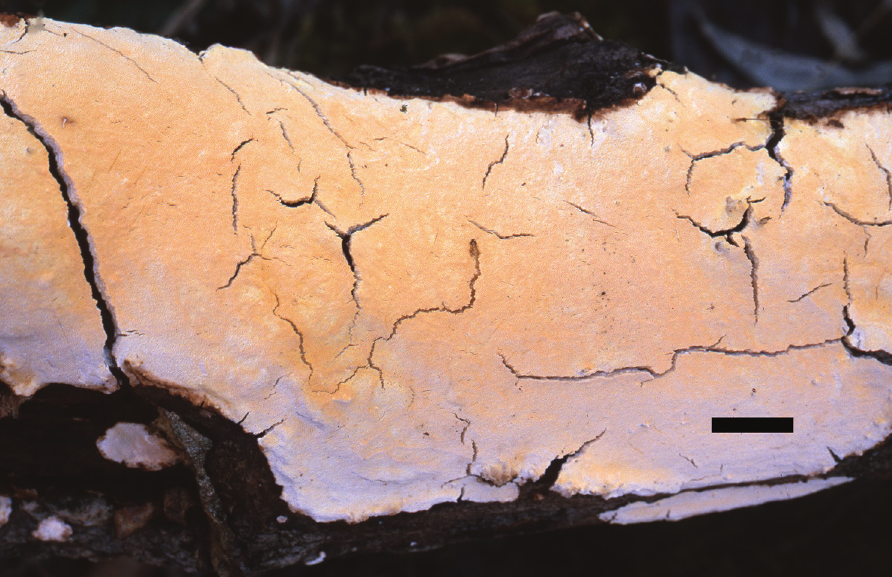
Figure 4. A basidiocarp of Perenniporia subcorticola (from Dai 3257). Scale bar: 1 cm. Photo by Yu- Cheng